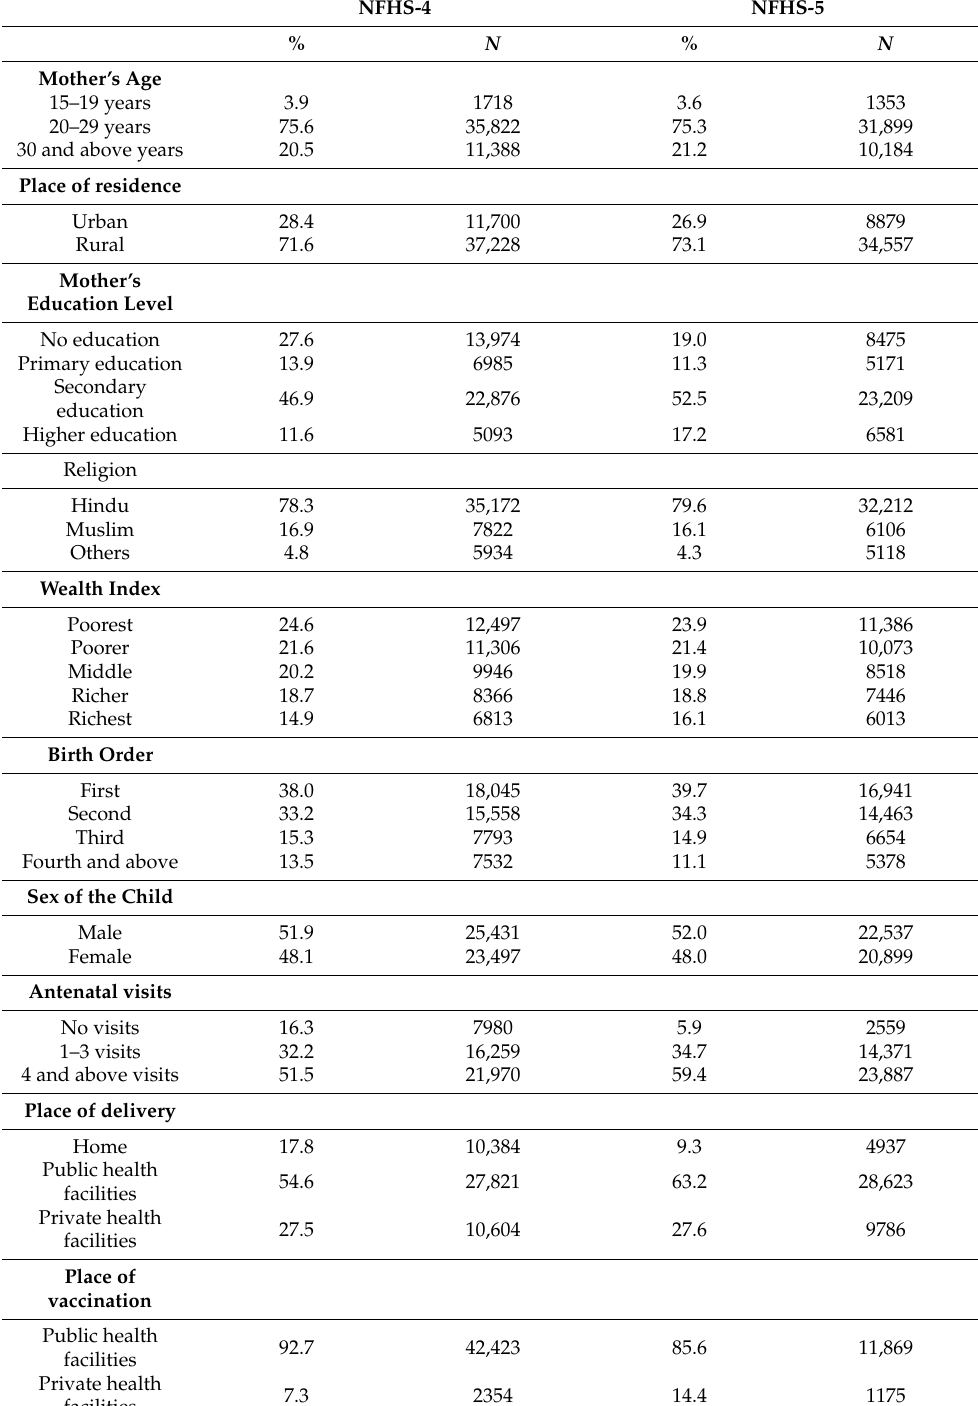
Table 2. Sample characteristics of the study